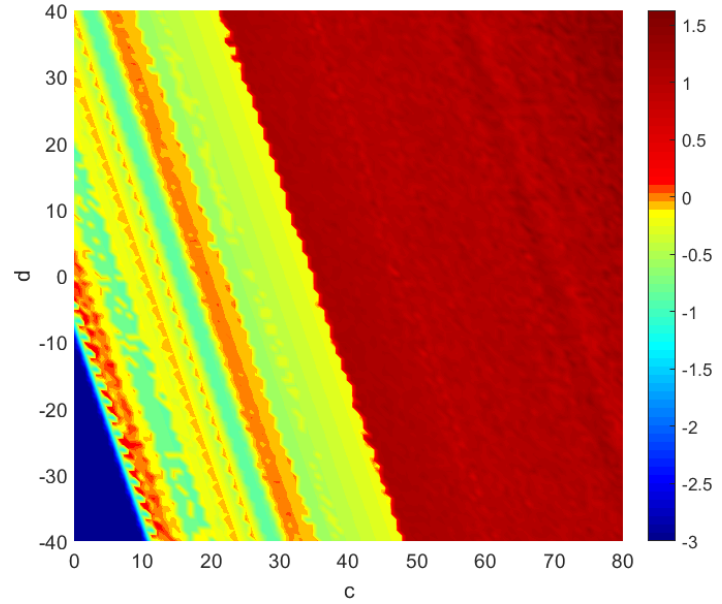
Figure 5. Two-parameter Lyapunov exponents diagram in ( c , d ) plane with initial values ( 1,1,1 ) .